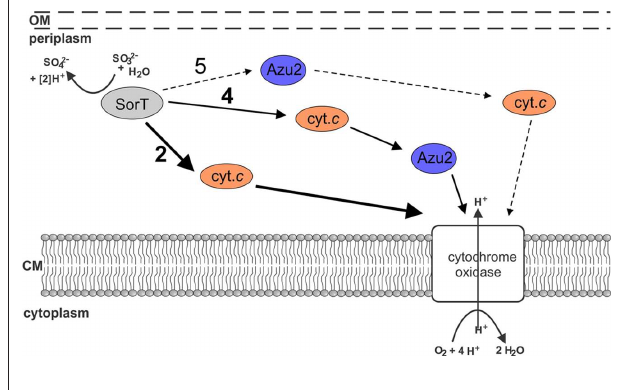
Figure 6 | Current working model of electron transfer pathways between SorT and the respiratory chain. The main pathway appears to be no. 2 using the Smc04048 cytochrome c as an electron carrier. It is also possible that both Smc04048 and Azu2 participate in electron transfer (pathways 4 + 5), however, based on present data it seems unlikely that pathway 5 would play a significant role in